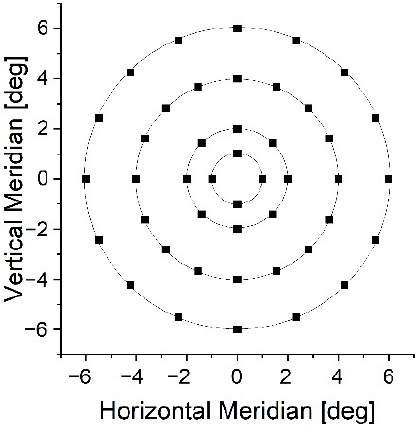
Figure 2. The distribution of retinal loci for sensitivity testing.